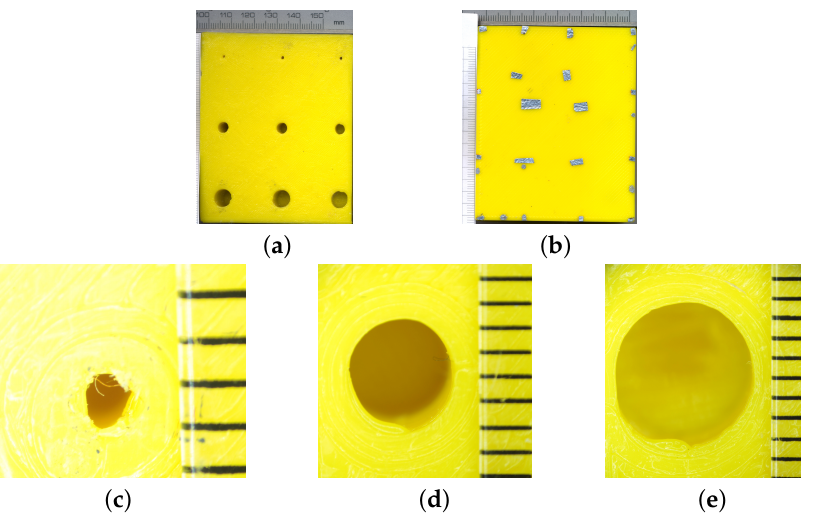
Figure 2. Photos of both sides of the sample ( a , b ), close-up of the defects with different diameters (mm): φ 1 ( c ), φ 4 ( d ), and φ 7 ( e ).